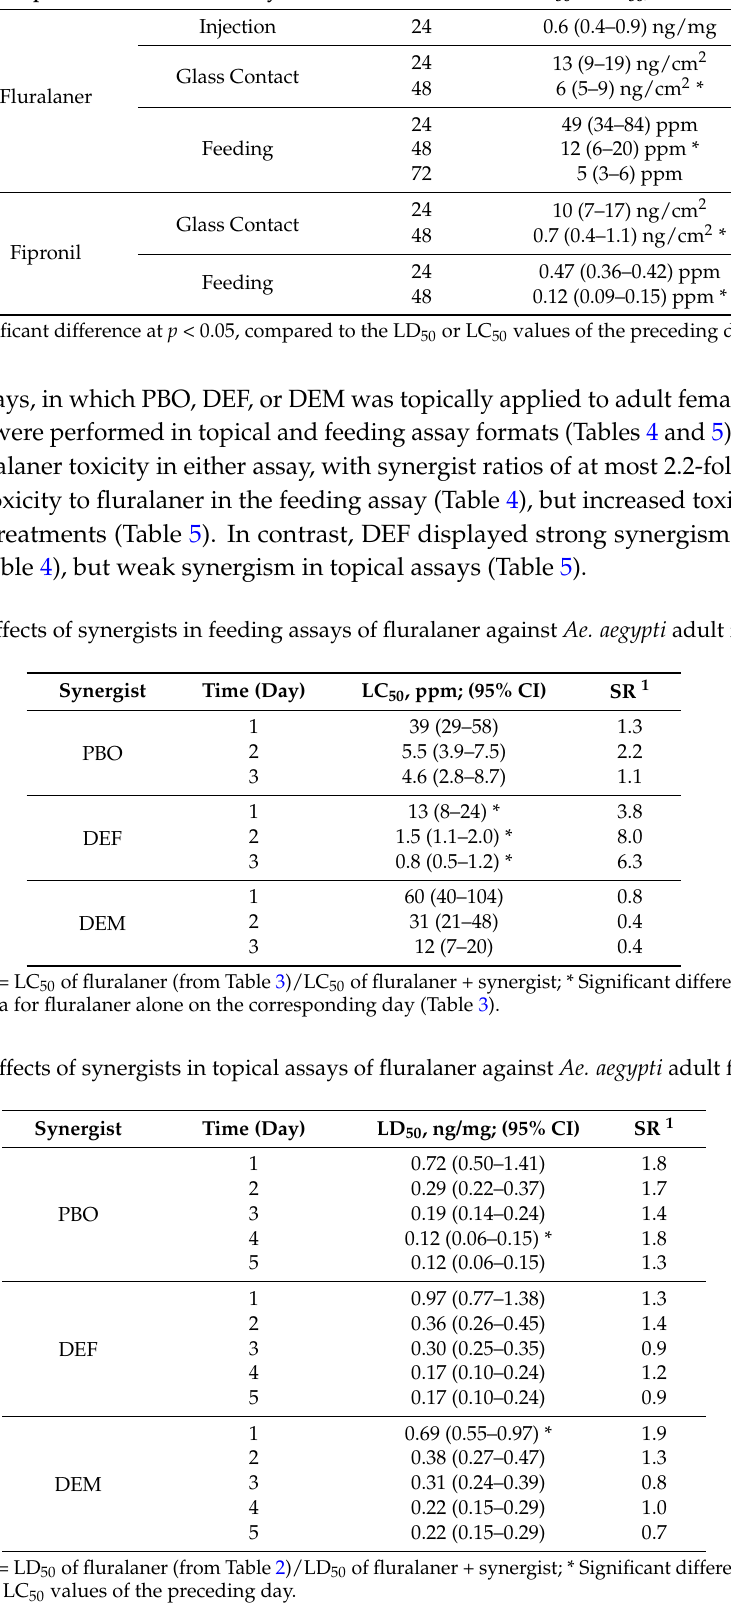
Table 3. Bioassays of fluralaner and fipronil on Ae. aegypti adult females. Compounds